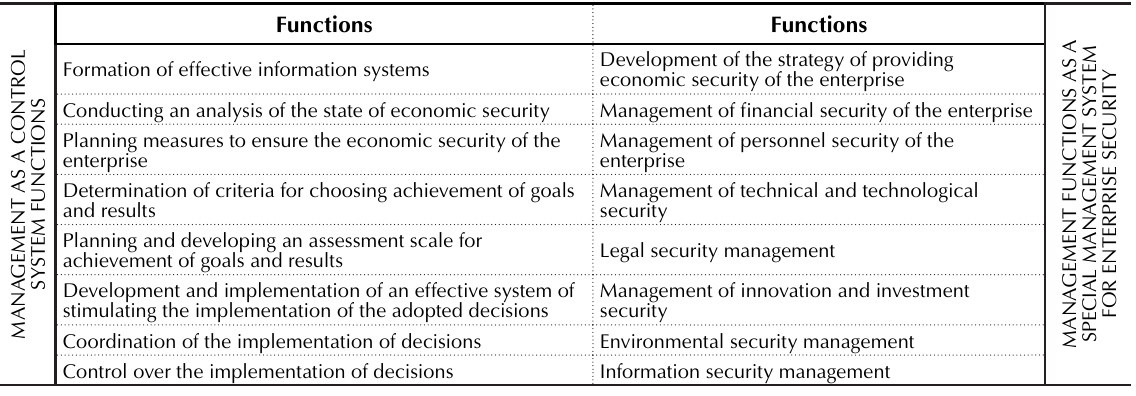
Source: Developed by the author.